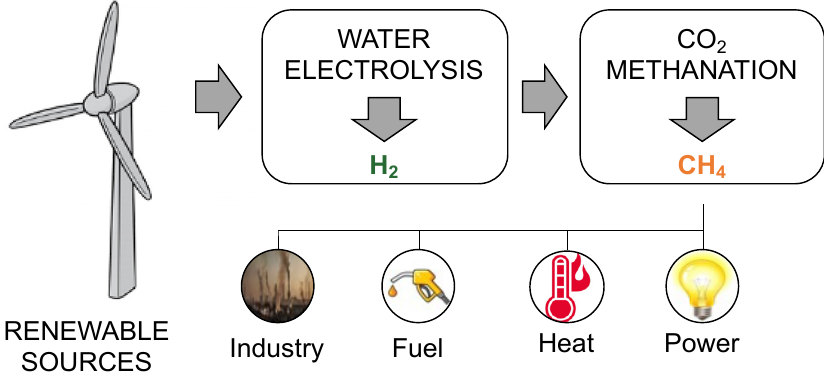
Figure 8. PtM process chain. From source to applications.